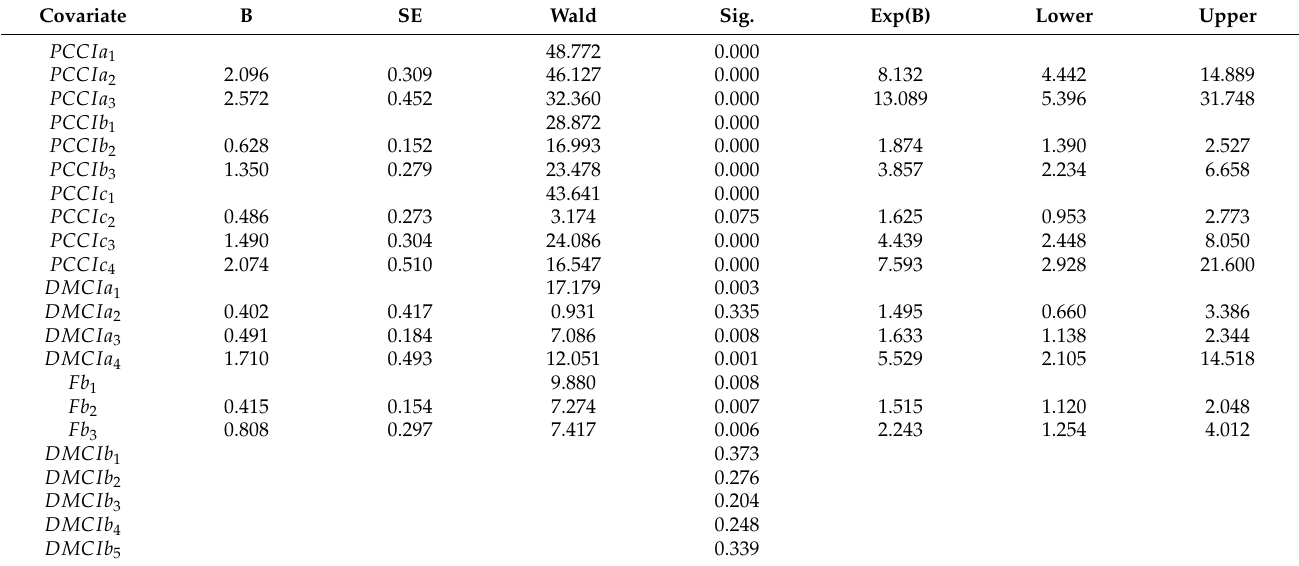
Table 6. Regression Coefficients and Significance